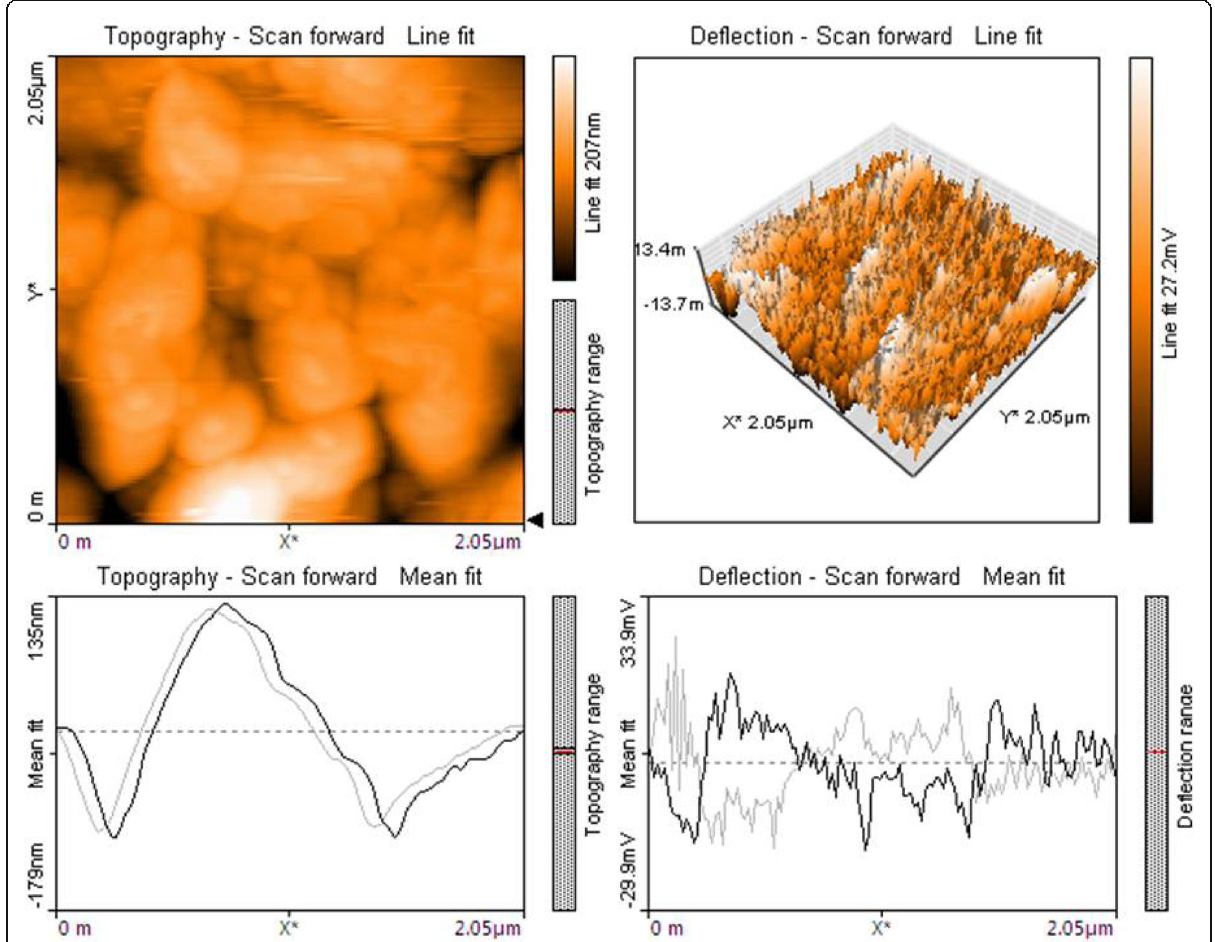
Fig. 7 AFM analysis of the biosynthesised selenium